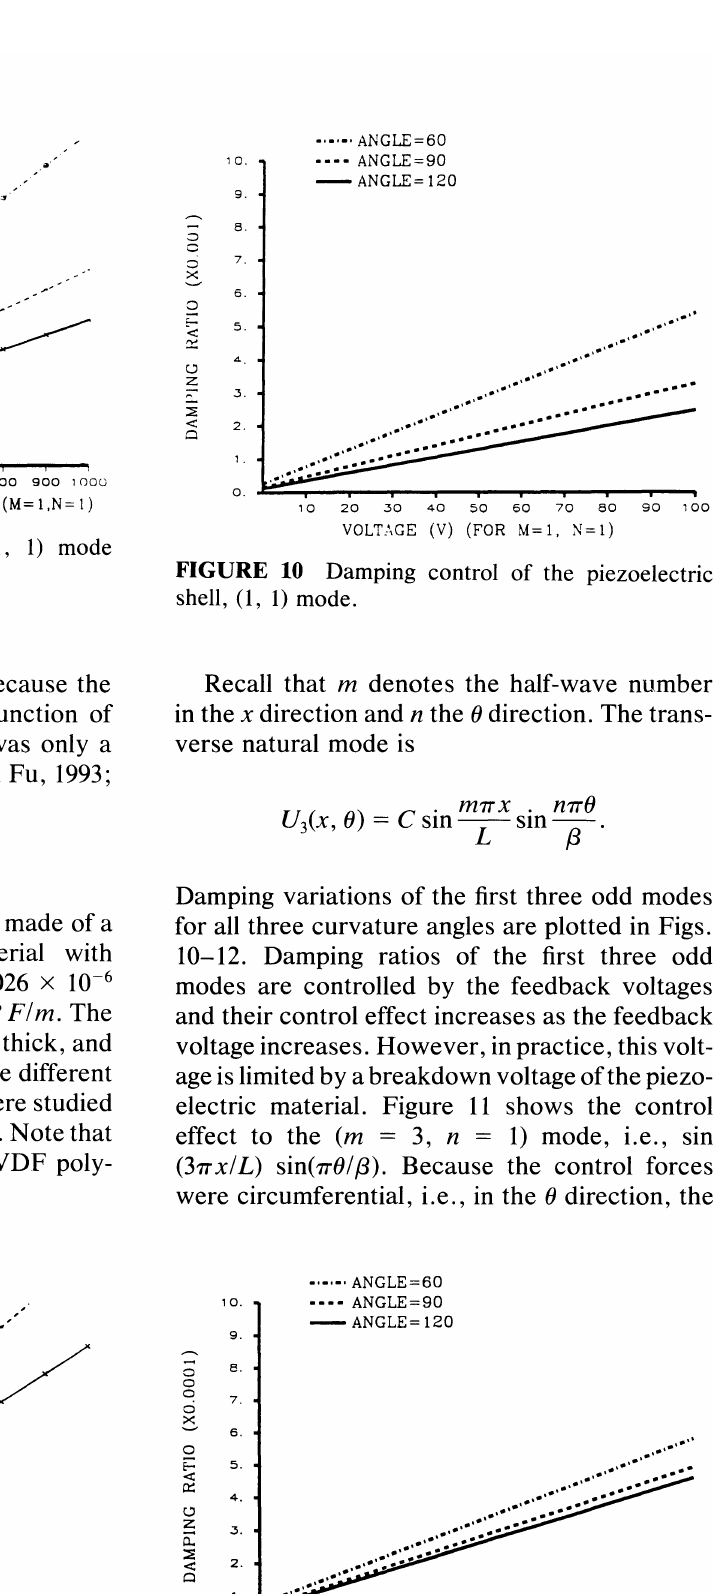
FIGURE 9 Damping control of the (1, 1) mode (O.5-mm shell, 25-,um actuator).